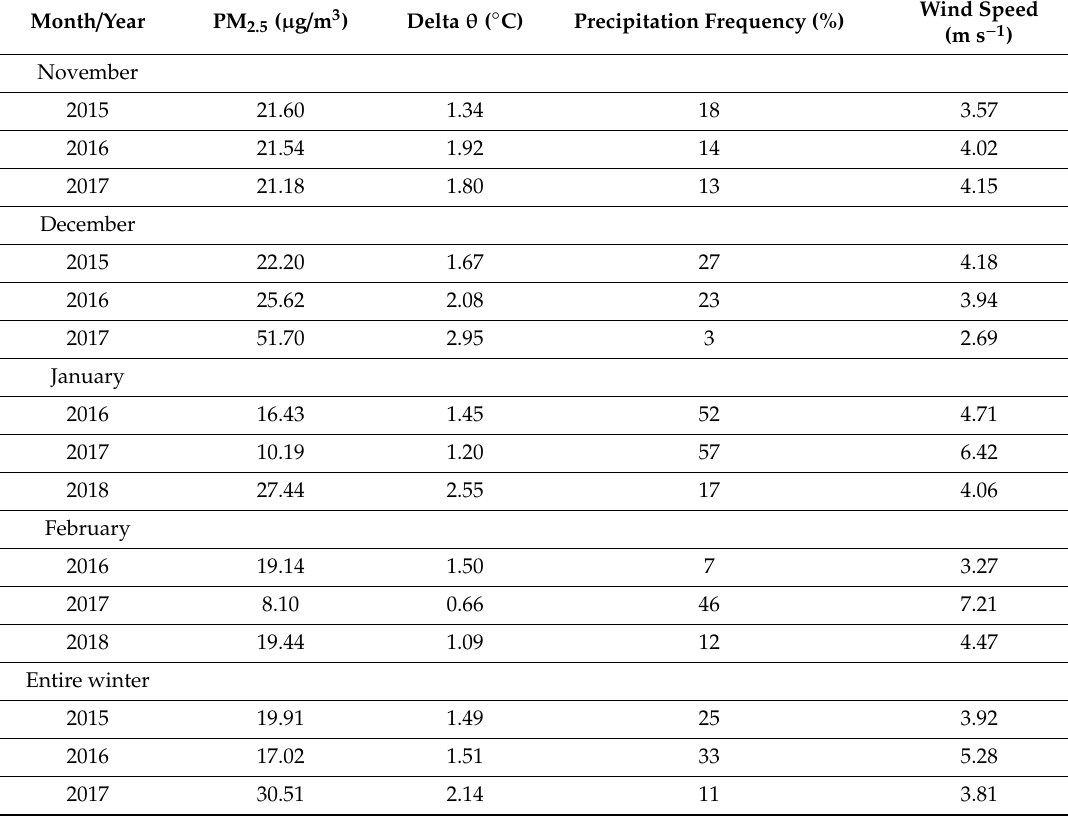
Table 5. PM 2.5 , delta θ , precipitation frequency and wind speed average by month for the winter of